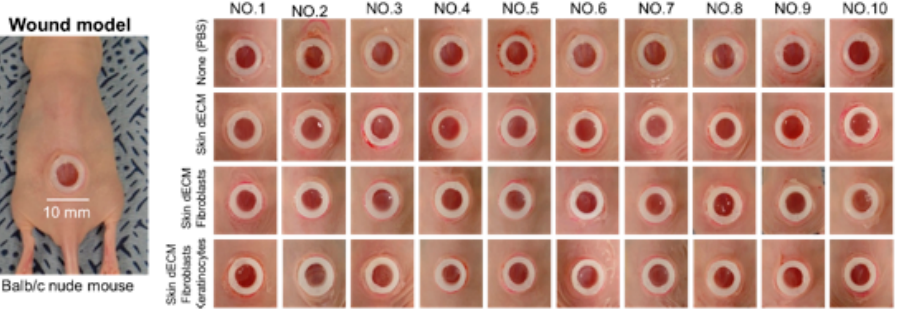
Figure 2. Generation of chimney structures and skin substitutes by 3D printing: ( A , B ) fabrication of chimney structures using a 3D printer and preparation of skin substitutes via 3D cell-printing technology; ( C ) confirmation of uniform chimney model production in all experimental groups.